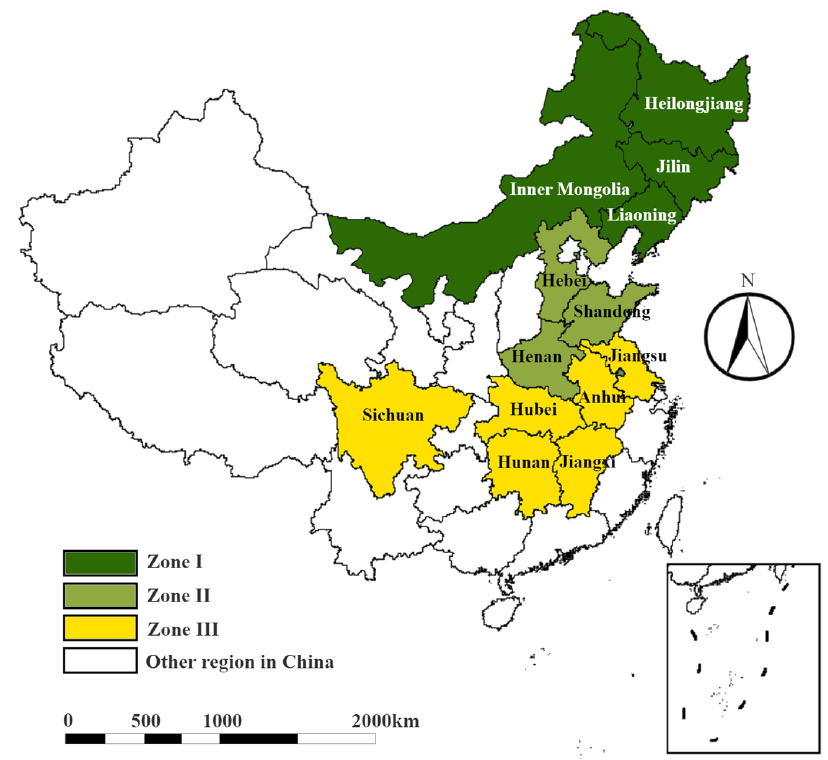
Figure 1. Study area and regional divisions.